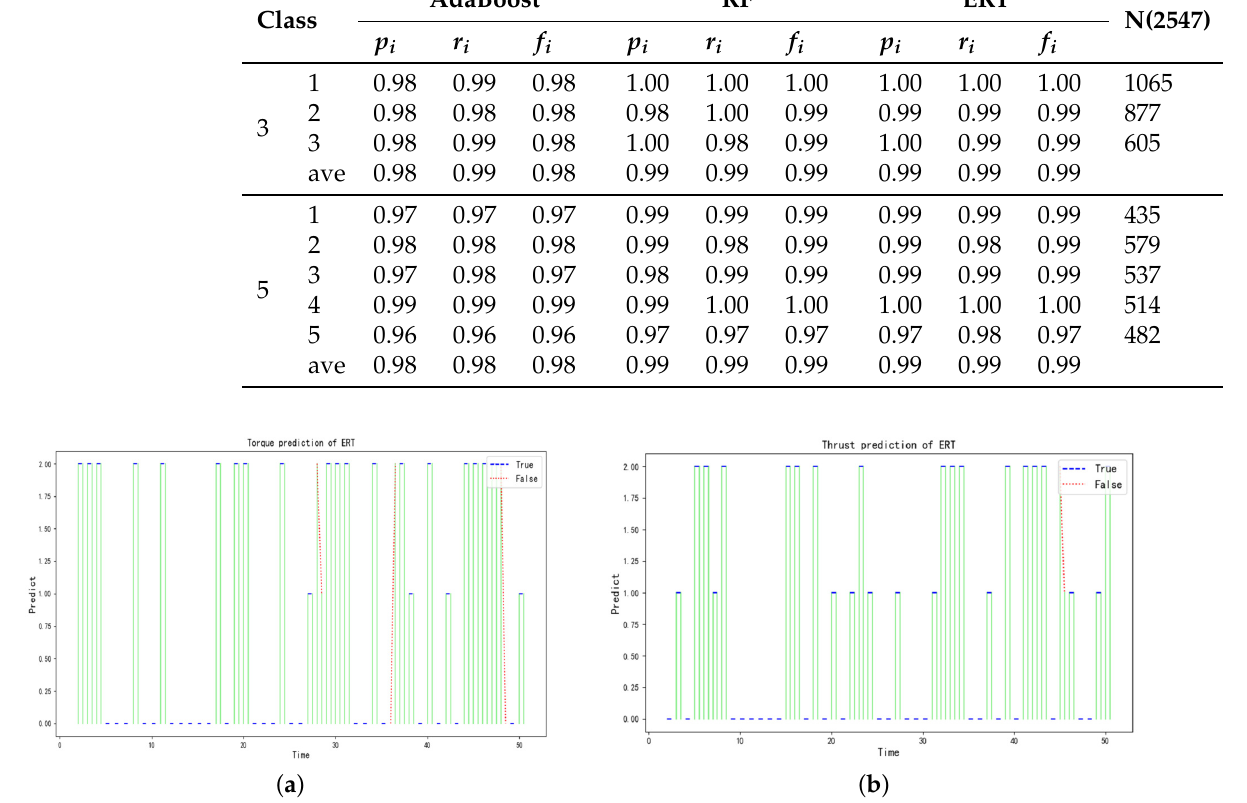
Figure 8. Comparisons between actual and predicted states of the ERT model under N s = 3: ( a ) Torque; ( b )